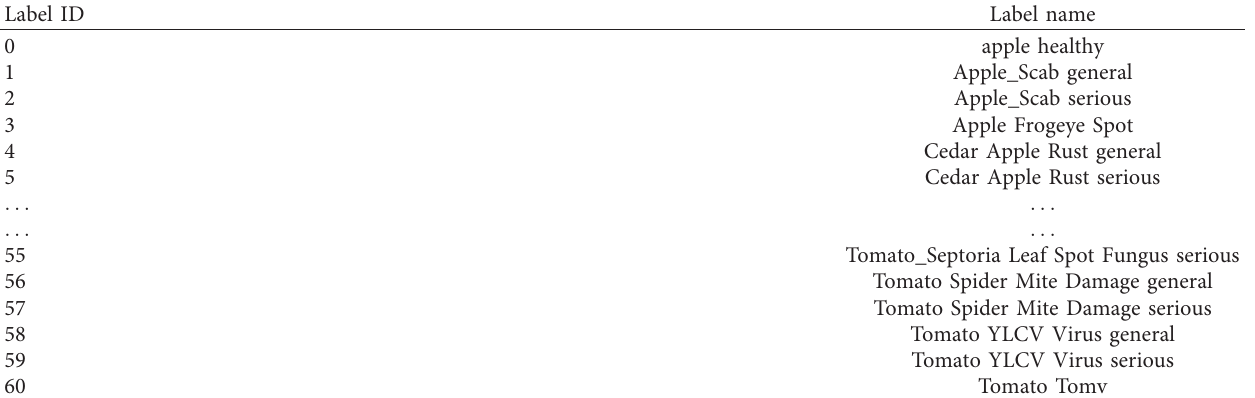
Table 2: Some labels of PlantVillage dataset.